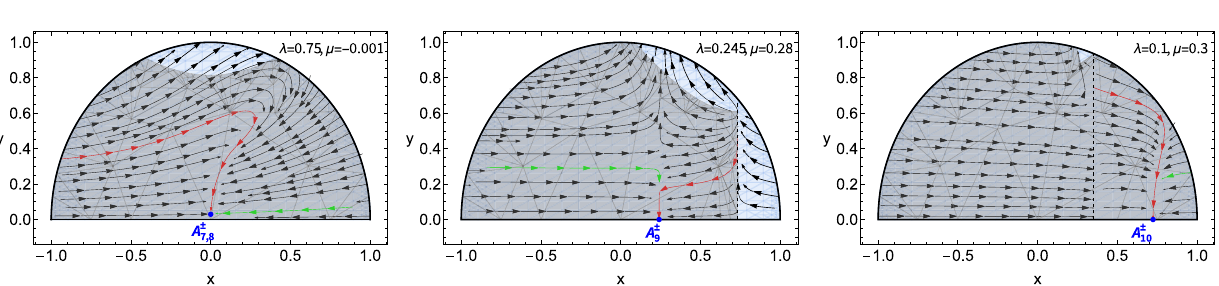
Fig. 1 Phase space portraits of the autonomous system on a x vs. y plane. The acceleration of the universe is possible within the gray- shaded region. The green and red lines are particular attractor trajec-